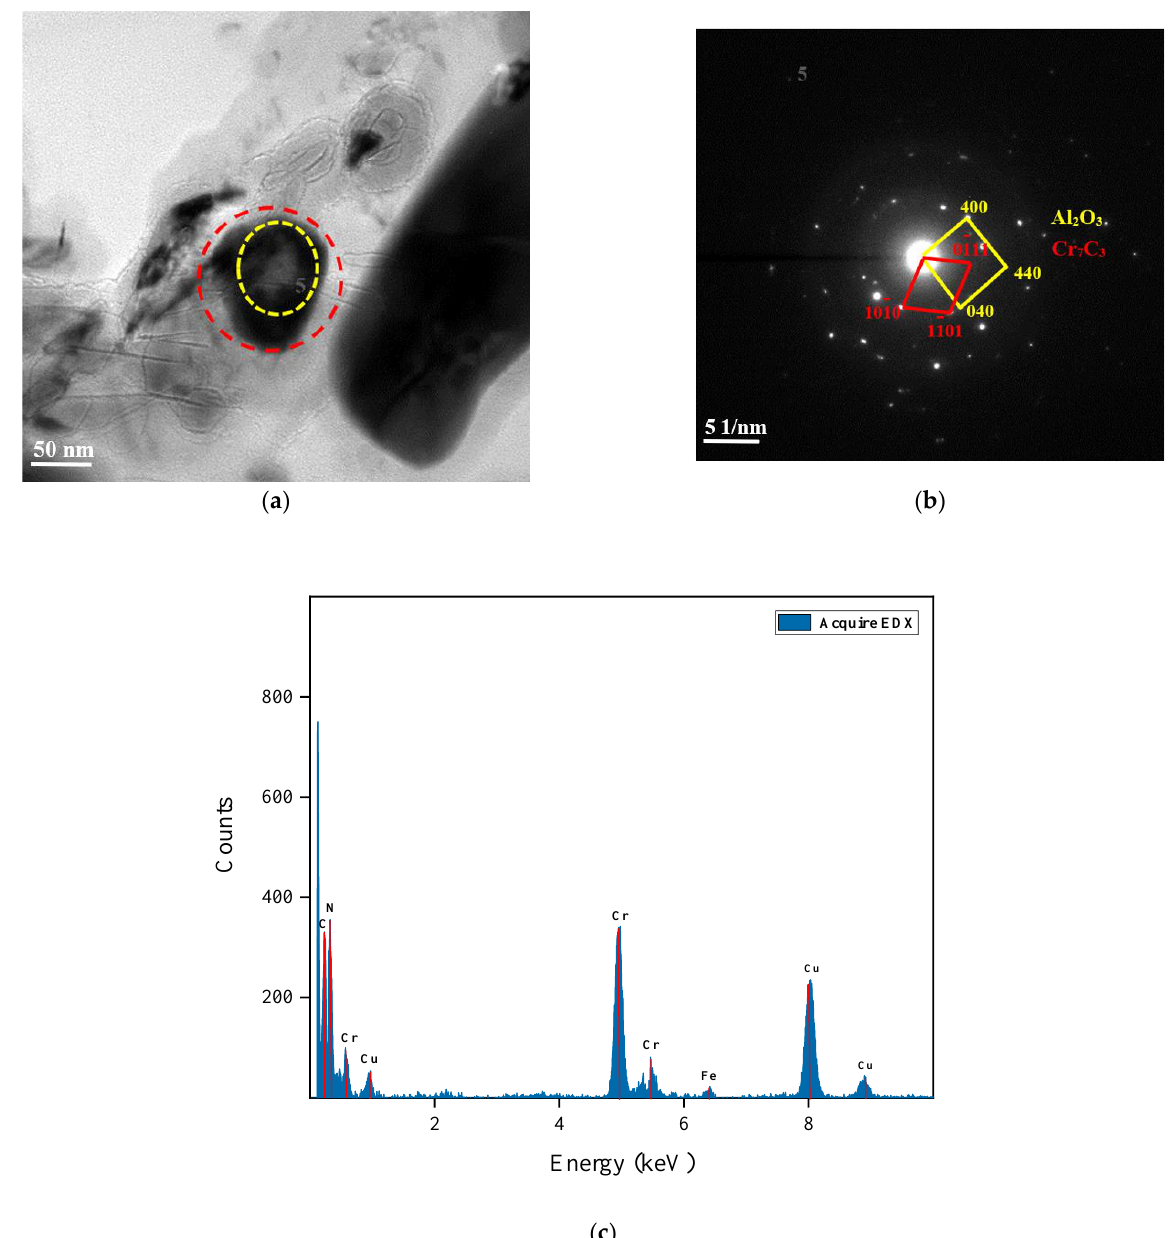
Figure 7. EDS mapping of Al 2 O 3 at micron scale; ( a ) SEM image; ( b ) O; ( c ) Al; ( d ) Nb; ( e ) Ti; ( f ) Mg.